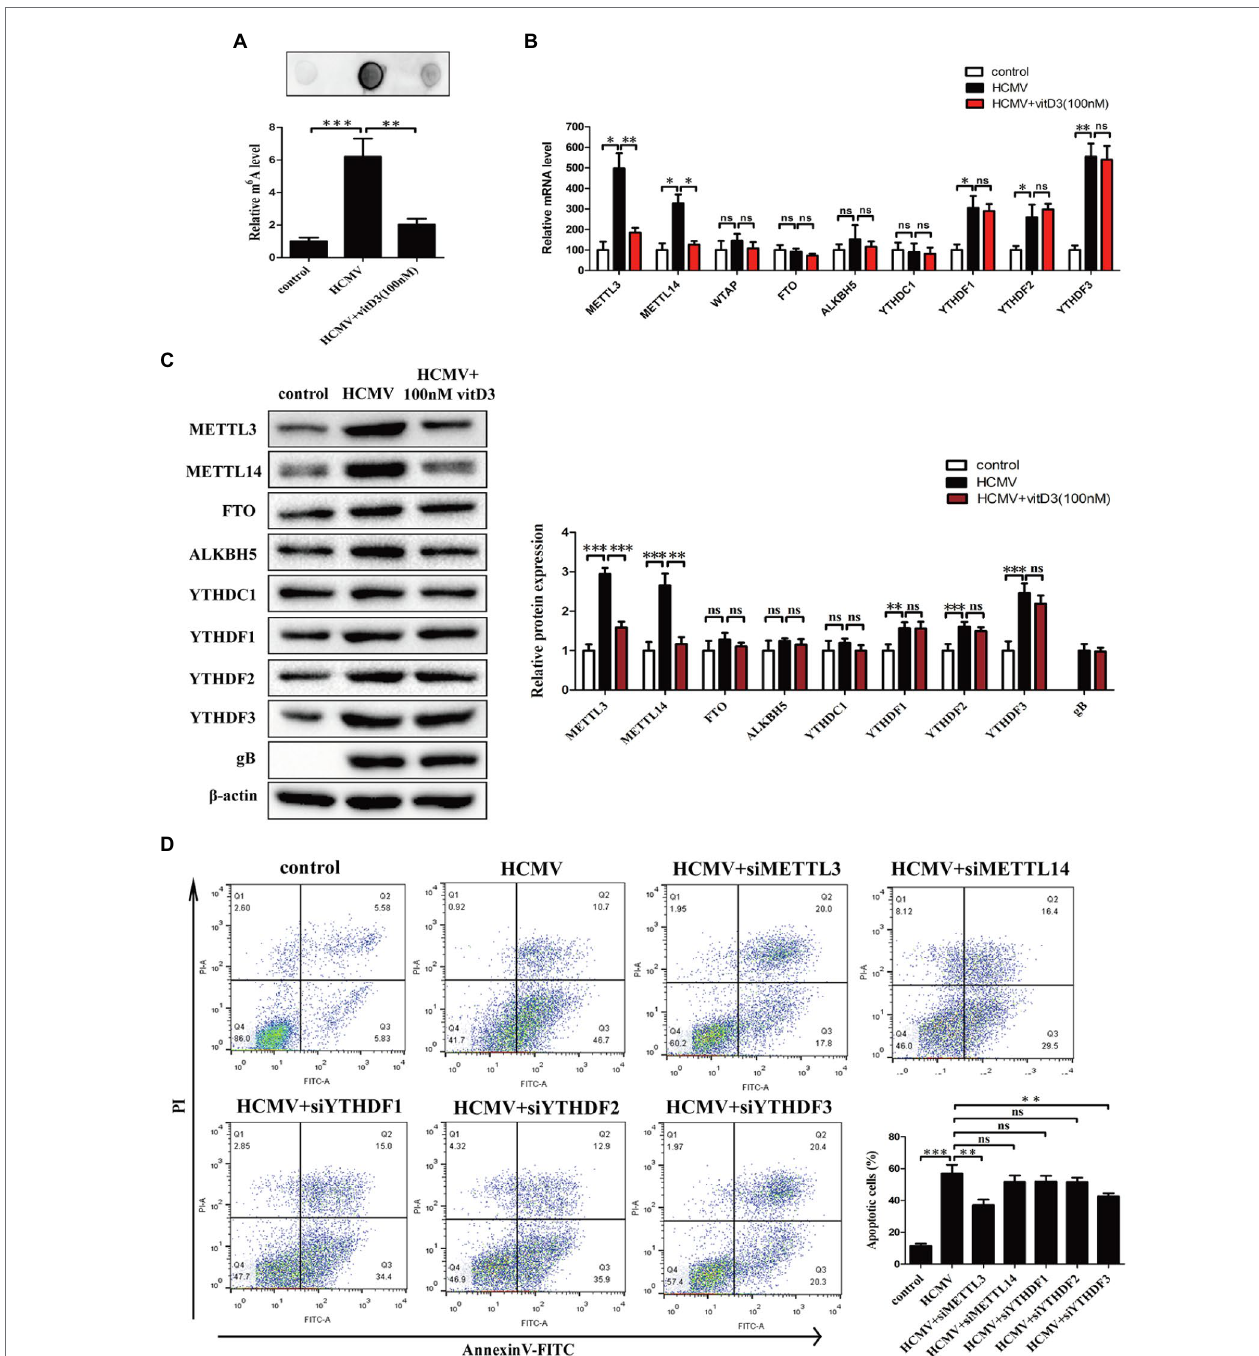
FIGURE 2 | Vitamin D3 negatively regulates the elevated m6A methylation levels induced by HCMV infection and inhibits HCMV-induced apoptosis by suppressing METTL3 expression in HAECs. HAECs were uninfected (control) or infected with VHL/E strain of HCMV [multiplicity of infection (MOI) = 5] for 4 days. In the vitD3- treated group, HAECs were continuously added with 100 nM vitD3 from the second to the fourth day of HCMV infection. After 4 days, HAECs were harvested for the following experiments. (A) RNA dot blot analysis of total m6A levels in the corresponding groups. Top, representative images of RNA dot blot; bottom, statistical charts for quantification of RNA dots. (B) qPCR analysis of mRNA levels of m6A modification-associated genes. (C) Western blot analysis of protein levels of m6A modification-associated genes. Left, representative graphs of three independent experiments; right, statistical charts with densitometric analysis. gB, a HCMV gene used to quantify HCMV infection. (D) Apoptosis was detected by Annexin-V/PI-labeled flow cytometric assay in different treatment groups and quantitative analysis. HAECs were transfected with siRNA of the indicated genes for 12 h and then exposed to HCMV. Left, representative images of flow cytometry; right, statistical charts. Apoptotic cells are calculated as the percentage of Annexin-V single-positive plus Annexin-V/PI double-positive cells. All data are expressed as the mean±SD of triplicate experiments. Columns, mean; error bars, SD. Student’s t- test, * p < 0.05, ** p < 0.01, and *** p < 0.001. ns: no significant